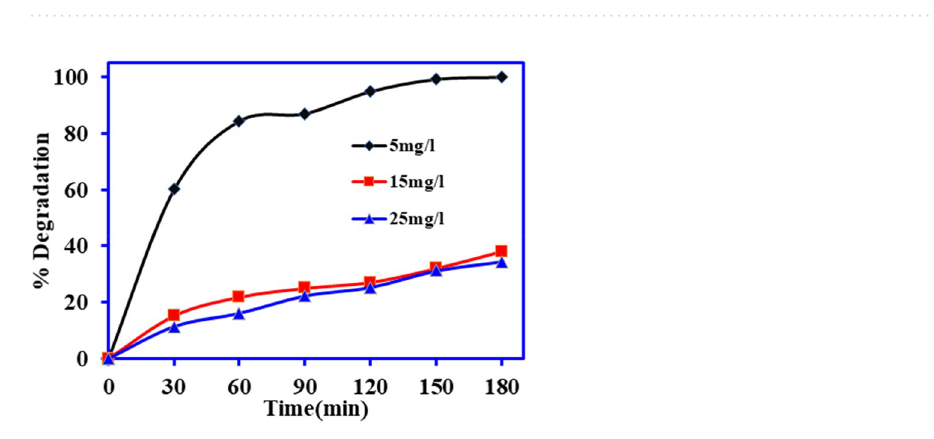
Figure 6. Photolytic degradation of DCF under UV irradiation. (DCF conc.—25 mg L −1 , vol.—100 mL, time—180 min) .